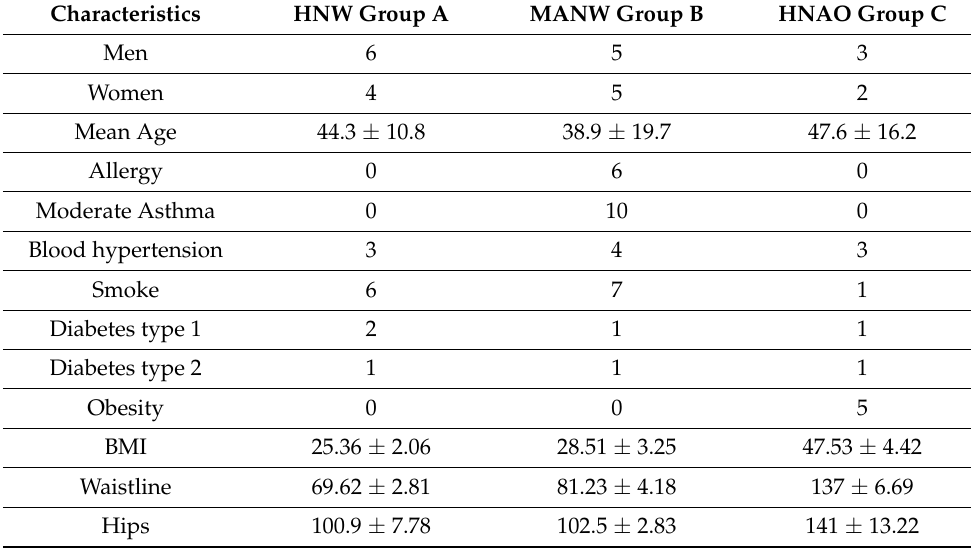
Table 1. Demographic